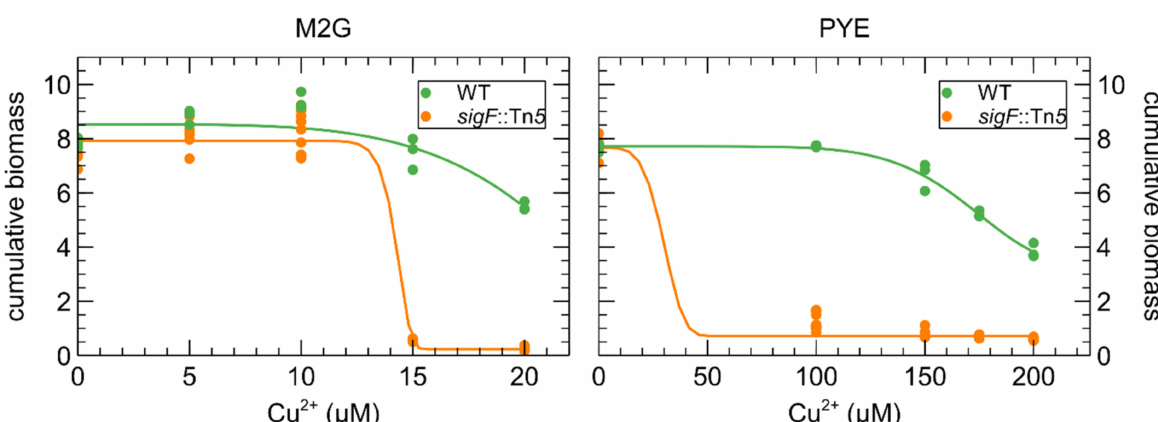
Figure 6. Effect of CuSO 4 concentration on the growth of C. crescentus (green) and a sigF ::Tn5 mutant (orange) in M2G ( left ) and PYE ( right ) medium. Cumulative biomass (time × OD 660 ) is the empirical area under the growth curve (0–24 h) for three biological replicates. A four-parameter Weibull distribution was used for non-linear